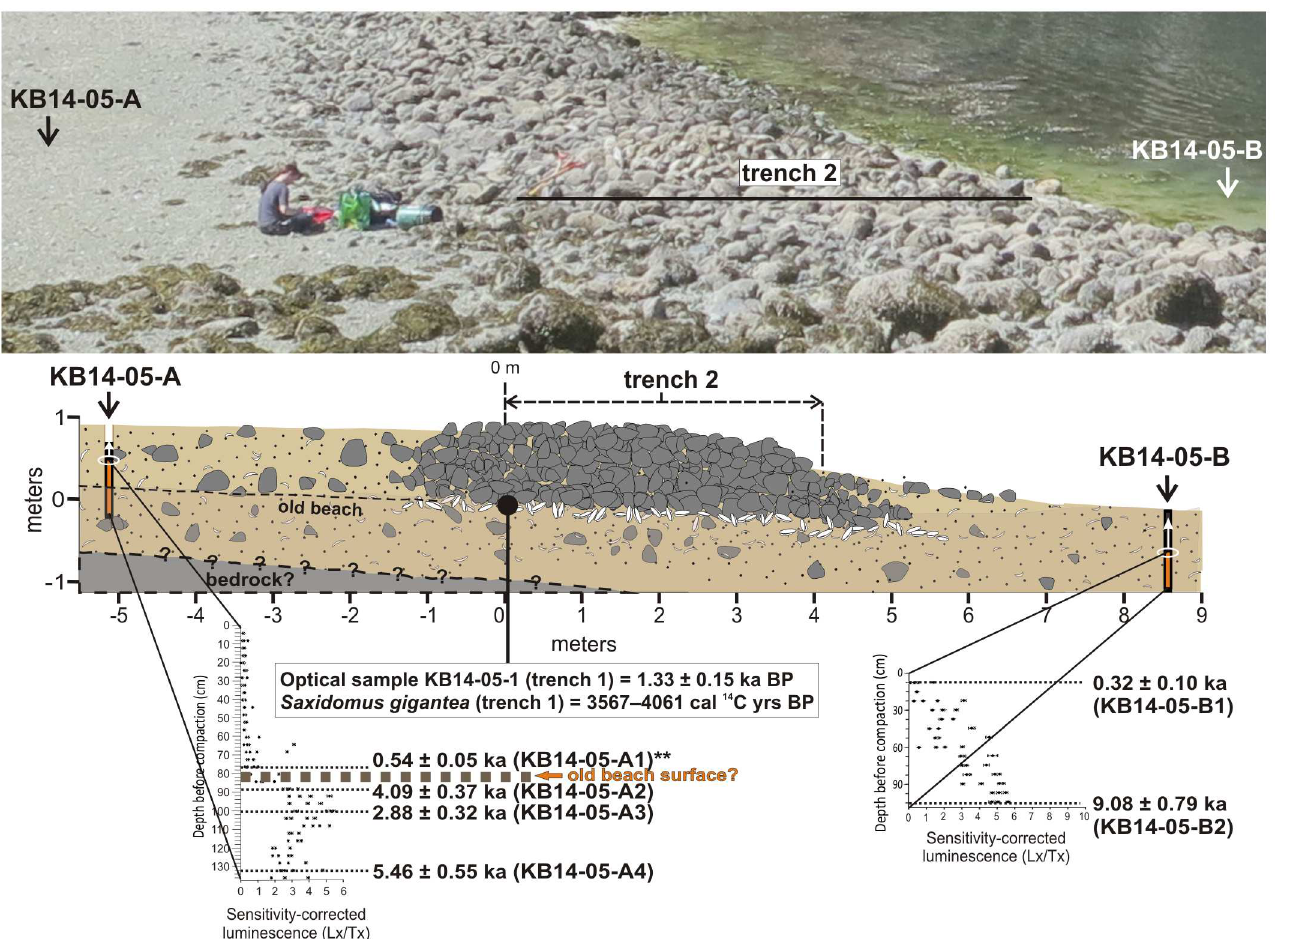
Fig 7. IRSL measurements and optical ages from core samples extractednear trench 2, site KB14-05. Due to compaction, the cores were only partially filled with sediment(brown shading) before extraction. Sensitivity-corrected IRSL measurements were made from subsamplescollectedevery 2 cm along the length of the core. Age estimates were obtainedaboveand belowthe horizon where the IRSL signalintensity increasesdramatically from almost negligiblelevels in core KB14-05-A. This dramatic increaseis interpretedto represent the pre-garden beach surface. Age estimates were also obtained from near the surface and near the base of core KB14-05-B. The ages of optical sample KB14-05-1 and a S . gigantea shell collectedfrom belowthe wall in trench 1 are shown for